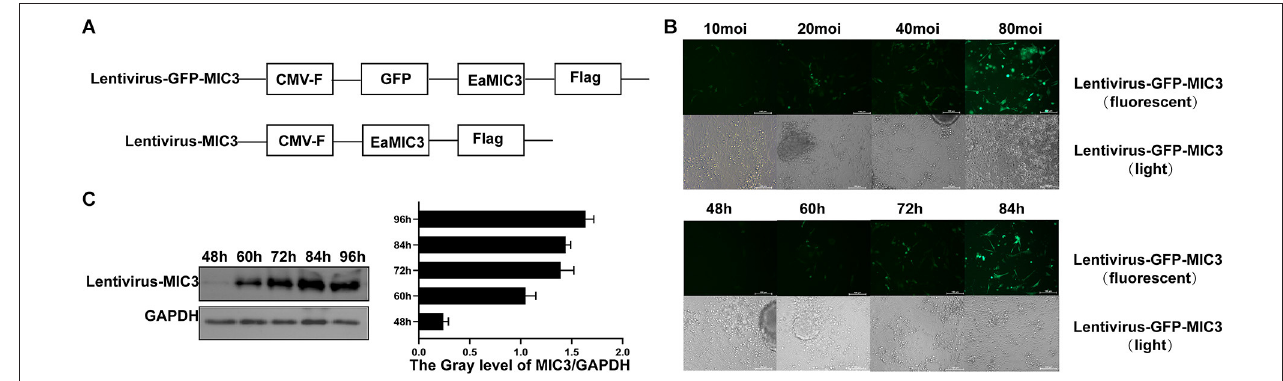
FIGURE 2 | Construction and detection of a recombinant lentivirus carrying MIC3 protein. (A) The construction strategy for the lentiviral vector carrying MIC3/green fluorescent protein or the MIC3 protein alone. (B) The cells were infected using recombinant lentivirus carrying MIC3/green fluorescent protein, and the optimal multiplication of infection (MOI) was obtained through the detection of green fluorescent protein expression by flow cytometry. (C) MIC3 was expressed in chick duodenal epithelial cells at different times. Western blot and gray analyses were used to study MIC3 expression in chick duodenal epithelial cells. The apoptosis/necrosis rate of chick duodenal epithelial cells was detected by Annexin V/PI assay after MIC3